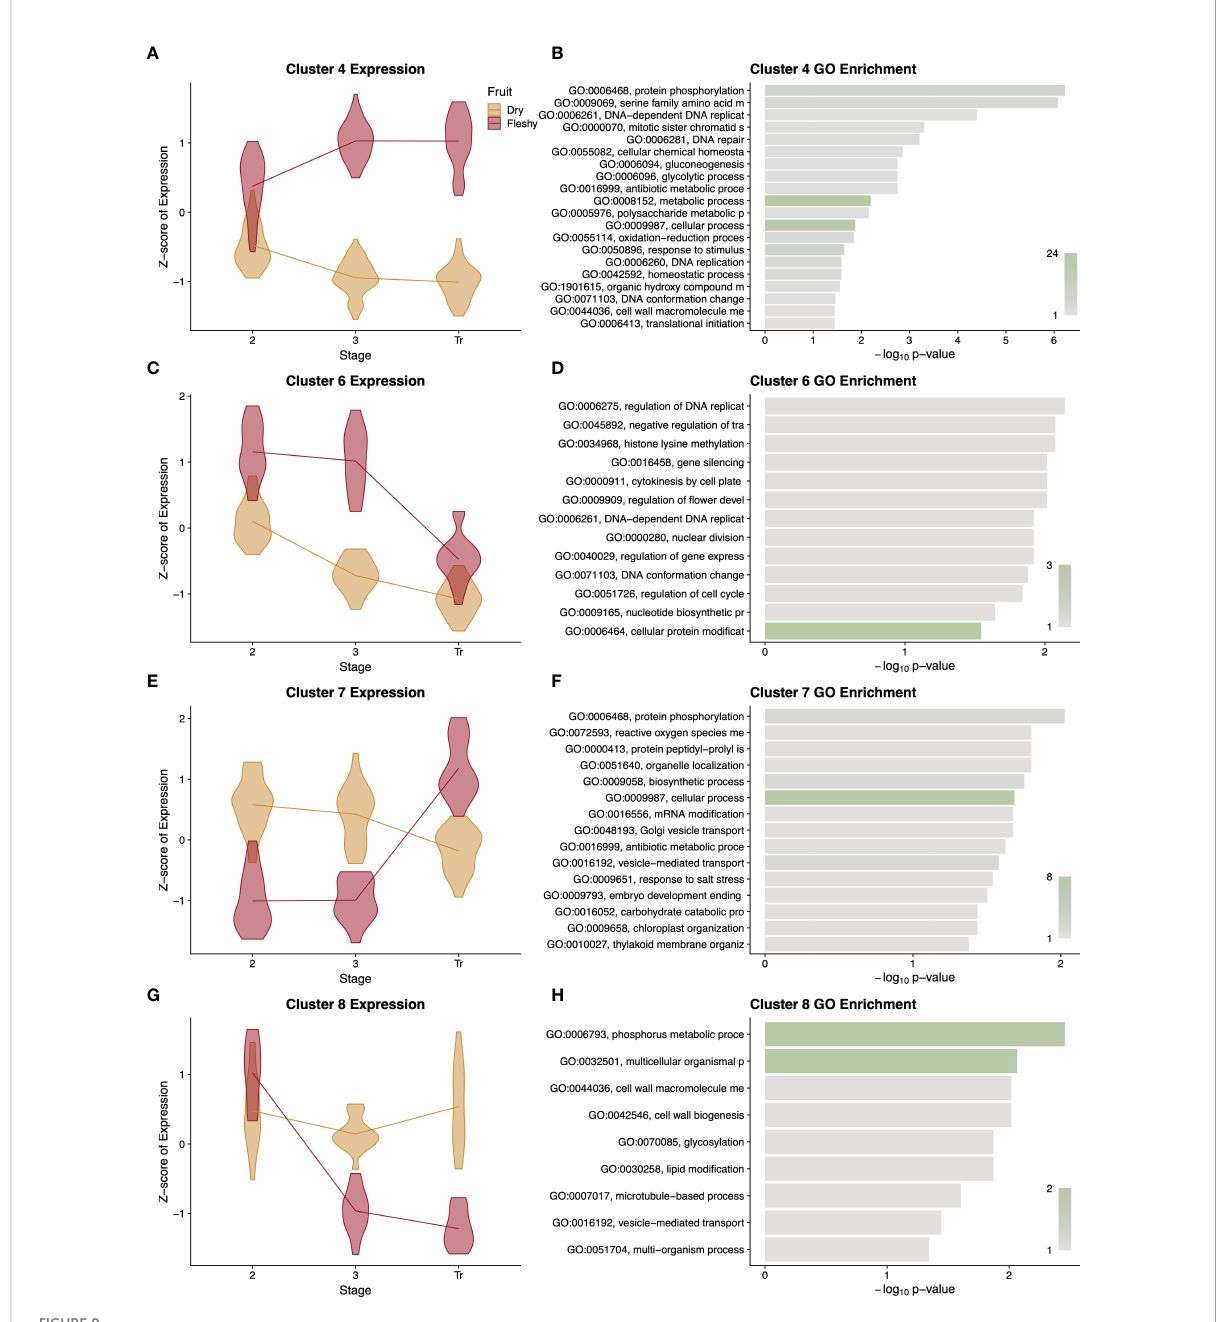
FIGURE 9 Summary of differentially expressed orthologous genes. Representative clusters of differentially expressed genes with patterns that differ between dry and fl eshy fruited taxa are presented with violin plots of normalised expression at each stage of development (A, C, E, G) along with a GO enrichment analysis (B, D, F, H) of the genes in that cluster. Clusters 4, 6, 7, and 8 comprise 366, 102, 108, and 96 orthologous genes, respectively. GO term descriptions to the left of the enrichment graphs are truncated for space and sorted by p-value. The bars are colored by the number of genes assigned to each GO term with legends in the lower right of the graph. Stages of fruit development in the axis of (A, C, E, G) are numbered sequentially followed by “ Tr ” for transition to mature